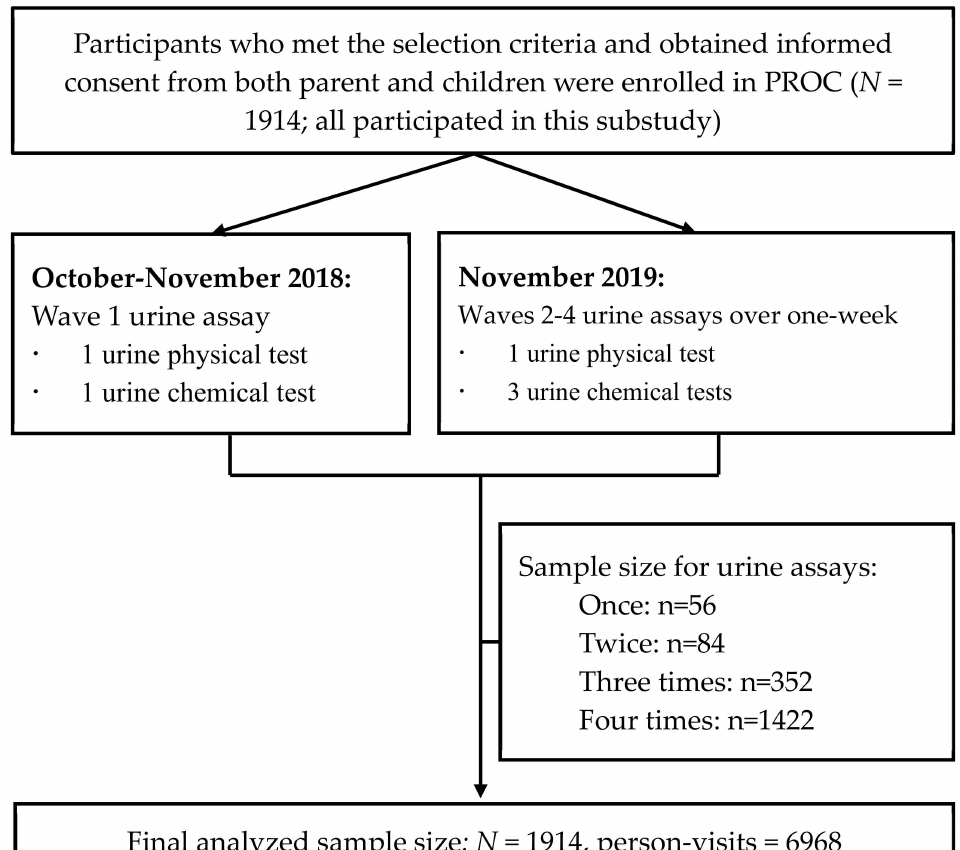
Figure 1. Flowchart of the procedure and frequency of urine collection for the study. Based on spot urinary potassium excretion, we calculated the estimated 24 h urinary potassium excretion [19] and the estimated potassium intake [20]: (cid:20) 0.1 × SpotUK ( − 4.72 × Age + 7.58 × Weight + 6.09 × Height − 64.50 ) 24hUK = 39.1 × 5.2 × SpotUCr 24hKIntake = 1.3 × 24hUK/1000 ( g/d ) We defined the abnormal cutoffs value as <1.5 g/d [21] for insufficient potassium intake, >0.2 mg/L for elevated β 2 -MG and tubular damage [22] and ≥ 20 mg/L for elevated MA and glomerular damage